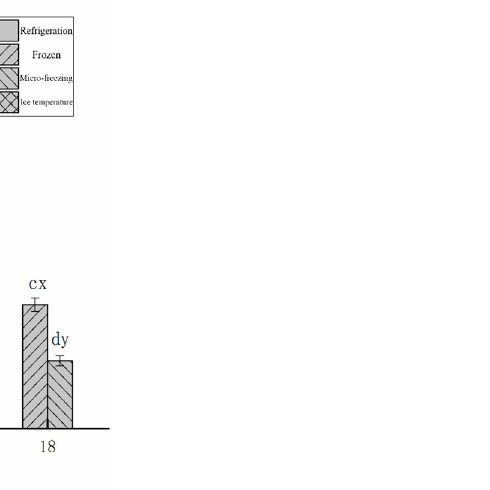
storage methods. d, day.